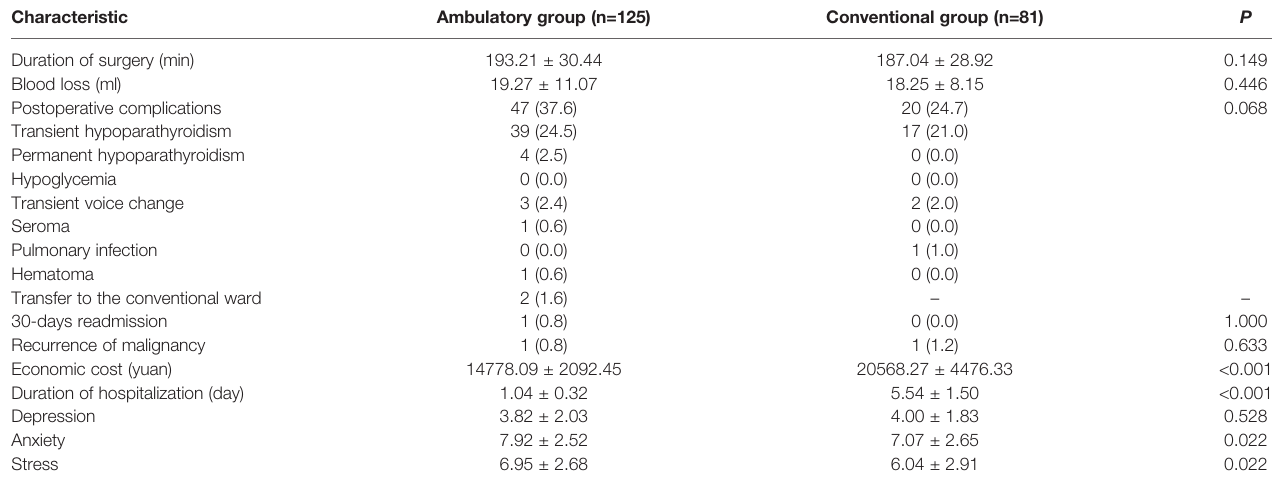
TABLE 5 | Subgroup analyses among patients with thyroid